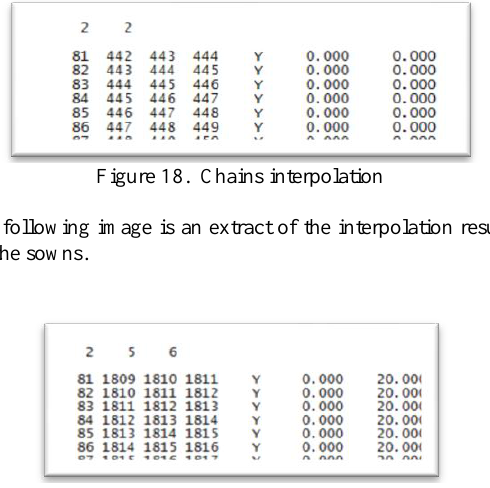
Figure 19. Contour sowns